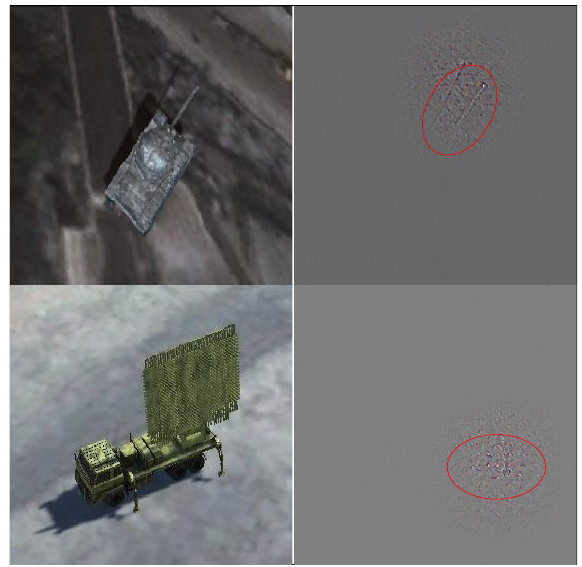
Figure 6. Maximum activation unit deconvolution visualization.